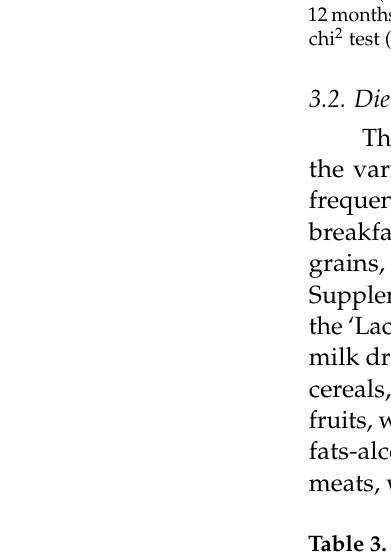
Table 3. Factor loadings for food groups in Principal Component Analysis (PCA)-derived dietary patterns and the Pearson’s correlation coefficients for food groups in the Polish-a MED ® among healthcare workers (n =